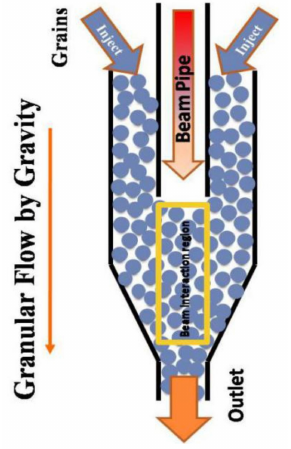
Figure 3. Schematic of a dense granular target (DGT).